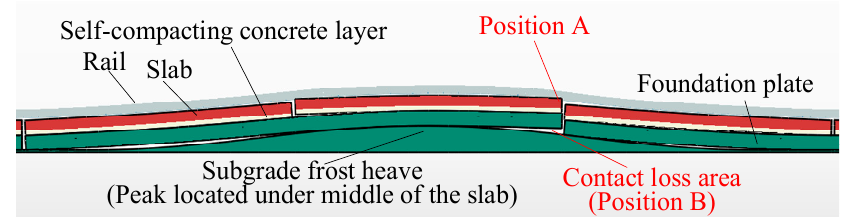
Figure 7. Deformation of the slab track before the vehicle running.